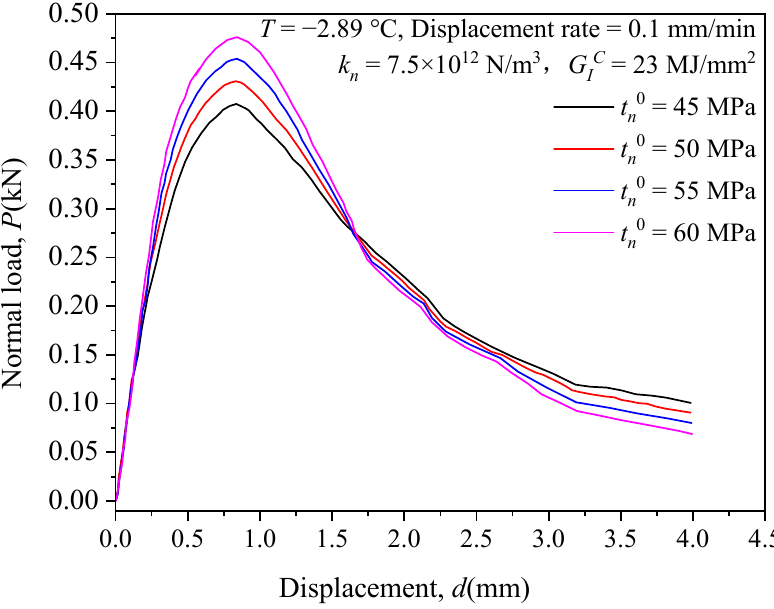
Figure 4. Normal load-displacement relationship curves for different initial damage stresses t 0 n .